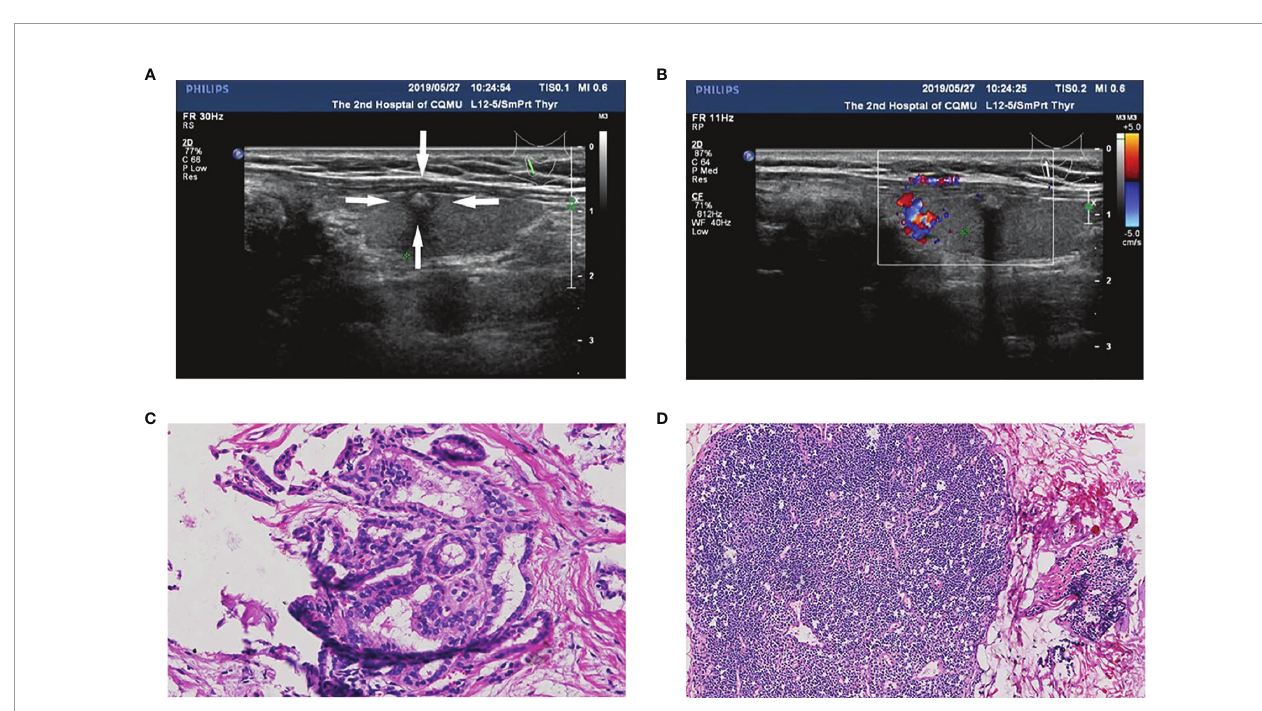
FIGURE 3 | A PTC patient (55-year-old female, 0.6 cm nodule) with non-central CLNM and positive BRAF V600E mutation. (A) The thyroid nodule had low-echo, microcalci fi cations, capsule contact, and unclear boundary on US image. (B) CDFI showed a lack of blood supply inside the nodule. (C) Pathologic examination con fi rmed the diagnosis of PTC. (D) Pathologic examination con fi rmed the diagnosis of non-central